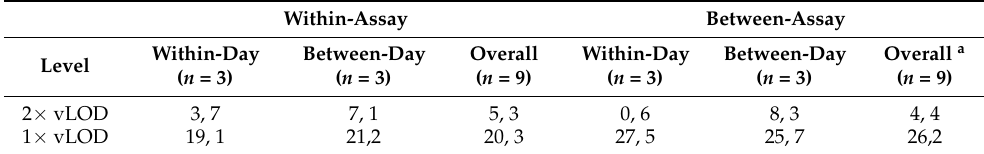
Table 4. Imprecision of the LFD-LFIA.